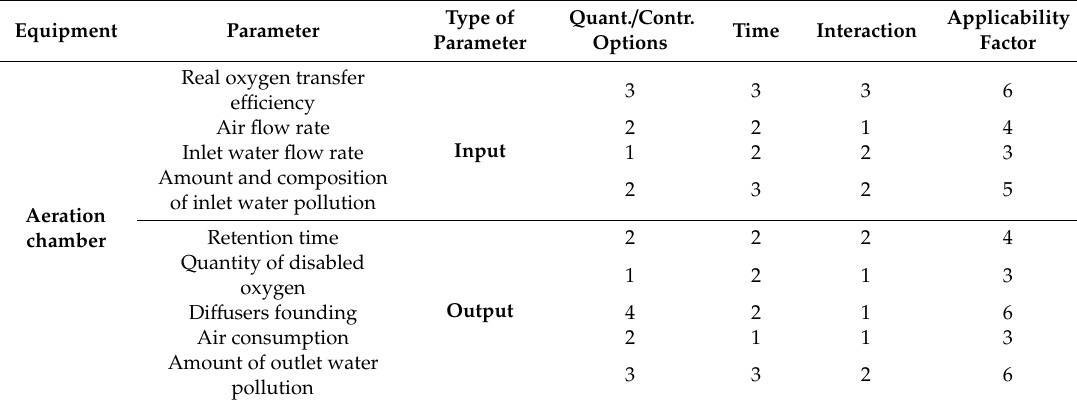
Table 10. Evaluation parameters of the aeration